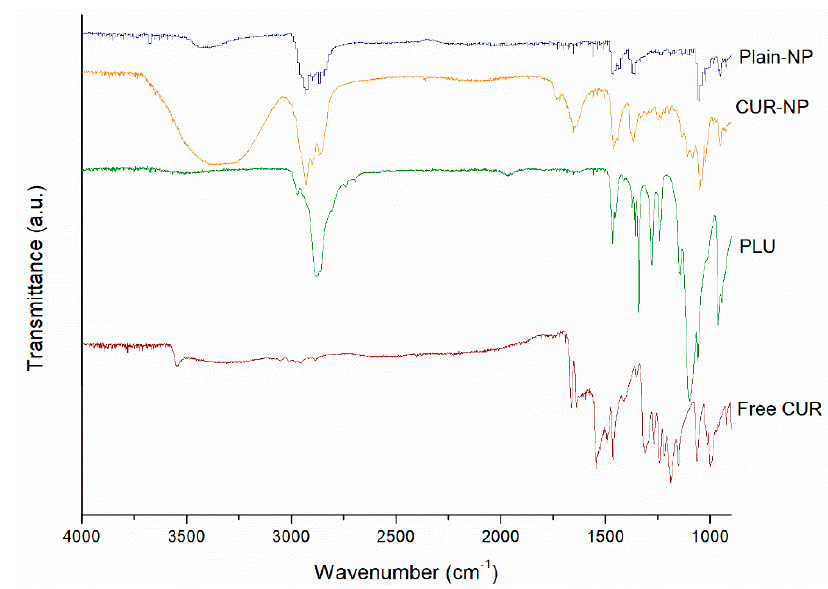
Figure 1. FT-IR spectra of CUR loaded PLU-NP, Plain-NP, and free CUR. The FT-IR spectra of the CUR-NP revealed the distinctive absorption peaks of CUR, indicating a mixture of signals from the curcuminoid, PLU, and CHO components. For instance, signals at 1465 cm − 1 and 1046 cm − 1 correspond to CH 2 and CH 3 deformation vibrations, ring deformation from CHO [24]. In addition, the main characteristic signals of CUR in the FT-IR spectra of CUR-NP correspond to 3339 cm − 1 was related to the stretching vibration of hydrogen-bonded -OH, 2937 cm − 1 was assigned to the stretching vibrations of methyl (CH 3 ), to 2857 cm − 1 was associate to C-H stretch aliphatic, 1648 cm − 1 was assigned to C-H-C stretching vibration, 1352 cm − 1 correspond to in-plane O-H bend and 1055 cm − 1 was related to C-O stretch, these signals for the CUR in the hybrid NPs further demonstrating that the drug was loaded onto the nanoparticle core. The PLU signals